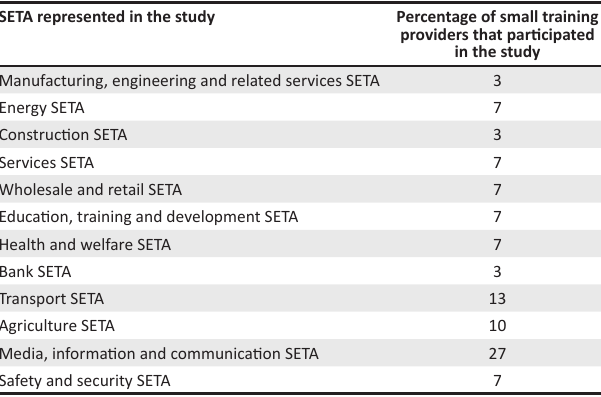
TABLE 2: Small training providers that participated in the study (as per their Sector Education and Training Authority accreditation). SETA represented in the study Percentage of small training providers that